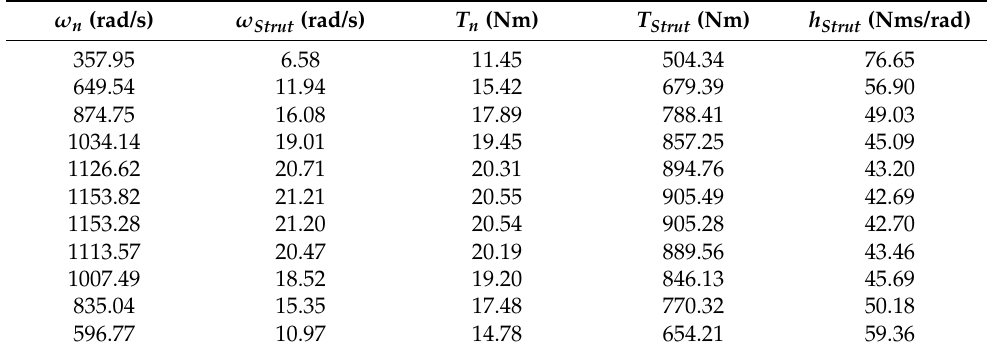
Table 4. Distribution of damping torque and damping coefficient with different shimmy